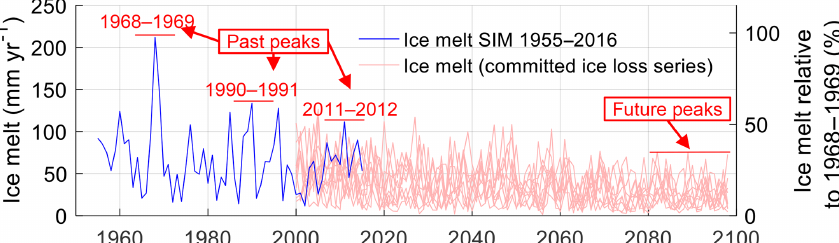
Figure 10. Variations in ice melt in the Maipo River basin for the past period (1955–2016, in blue) and each one of the 10 committed ice loss scenarios (light red). The peaks of ice melt over the past period and those at the final decade of the committed ice loss scenarios are highlighted in red. On the right axis, we set the ice melt estimated for the severe drought of 1968–1969 as 100%. Ice melt is computed for the Maipo River basin (i.e., runoff units are normalized by the basin area). For visual purposes, we present the committed ice loss scenarios using the period 2000–2100 in the x